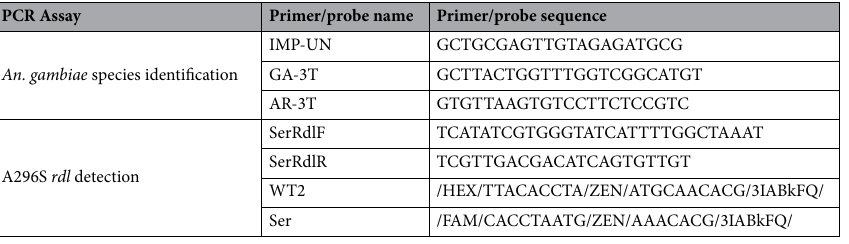
Table 3. PCR primer and probe